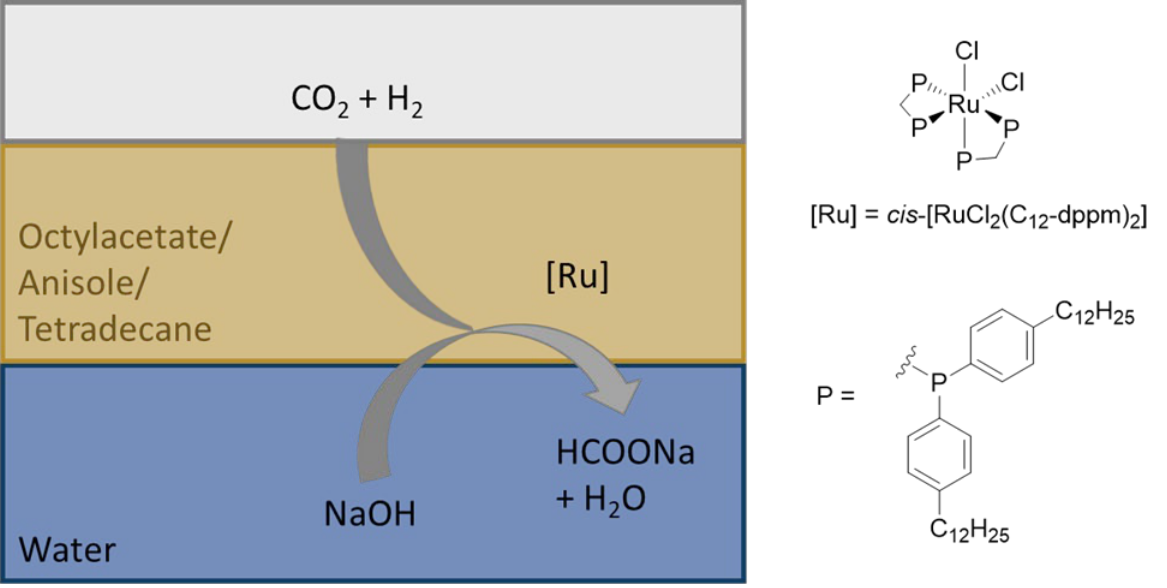
Figure 7. Schematic depiction of the biocompatible, multiphasic system for catalytic conversion of CO 2 and H 2 to sodium formate. CO 2 and H 2 to sodium formate.